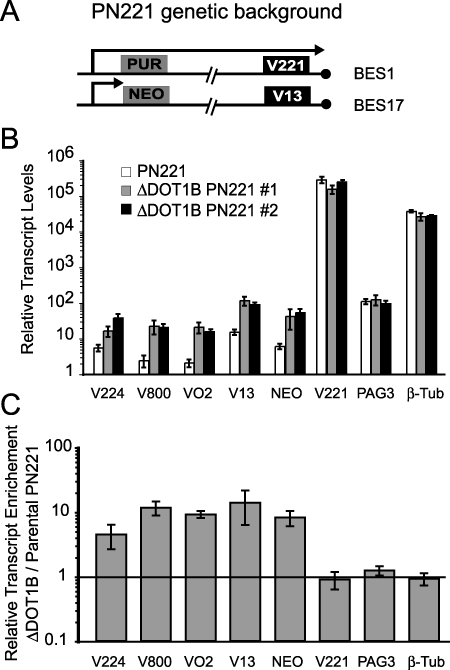
Disruption of DOT1B Results in Derepression of Silent VSGs(A) Schematic representation of PN221 genetic background, in which the actively transcribed BES1 is tagged with a PUR and the silent BES17 is tagged with NEO. VSG221 (MITat1.2) and VSG13 (MITat1.13) genes are located ∼50 kb downstream of the promoter (arrow) and ∼1 kb upstream of the telomere (circle).(B) Transcript quantification by quantitative RT-PCR of WT PN221 and two ΔDOT1B PN221 bloodstream clones, grown in the presence of 1 μg/ml puromycin. VSG224 (MITat1.3), VSG800 (MITat1.18), VSG VO2 (MITat1.9), VSG13, and NEO are genes present in silent BESs, whereas VSG221 is actively transcribed in BES1. PAG3 is present in one procyclin locus, which is transcriptionally downregulated in bloodstream forms. β-Tubulin genes are present in a tandem array that is transcribed by RNA polymerase II. Actin was used as the reference gene. Error bars indicate the standard deviation of sextuplicates of the same cDNA sample.(C) Relative enrichment of ΔDOT1B transcripts relative to the wild-type parental reference (average of four independent measurements). When column height is >1, ΔDOT1B transcript levels are higher than those in parental PN221.